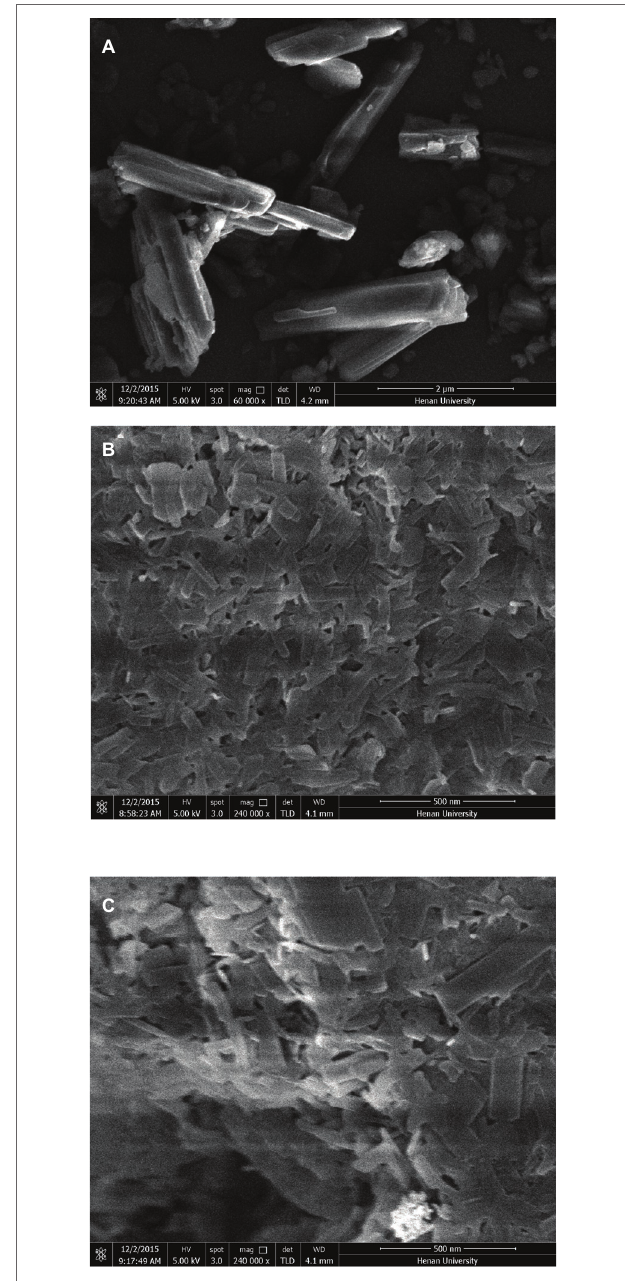
FIGURE 2 | SEM images of (A) crude ITZ, (B) ITZ-Nanos before lyophilizing, and (C) ITZ-Nanos after lyophilizing.